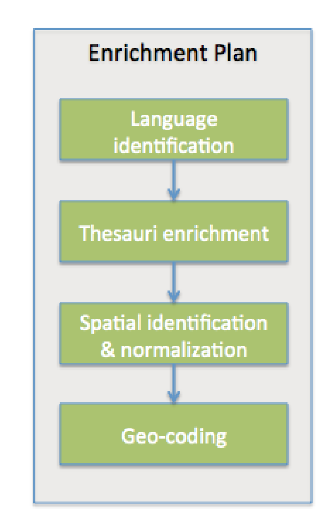
Figure 5. Enrichment services